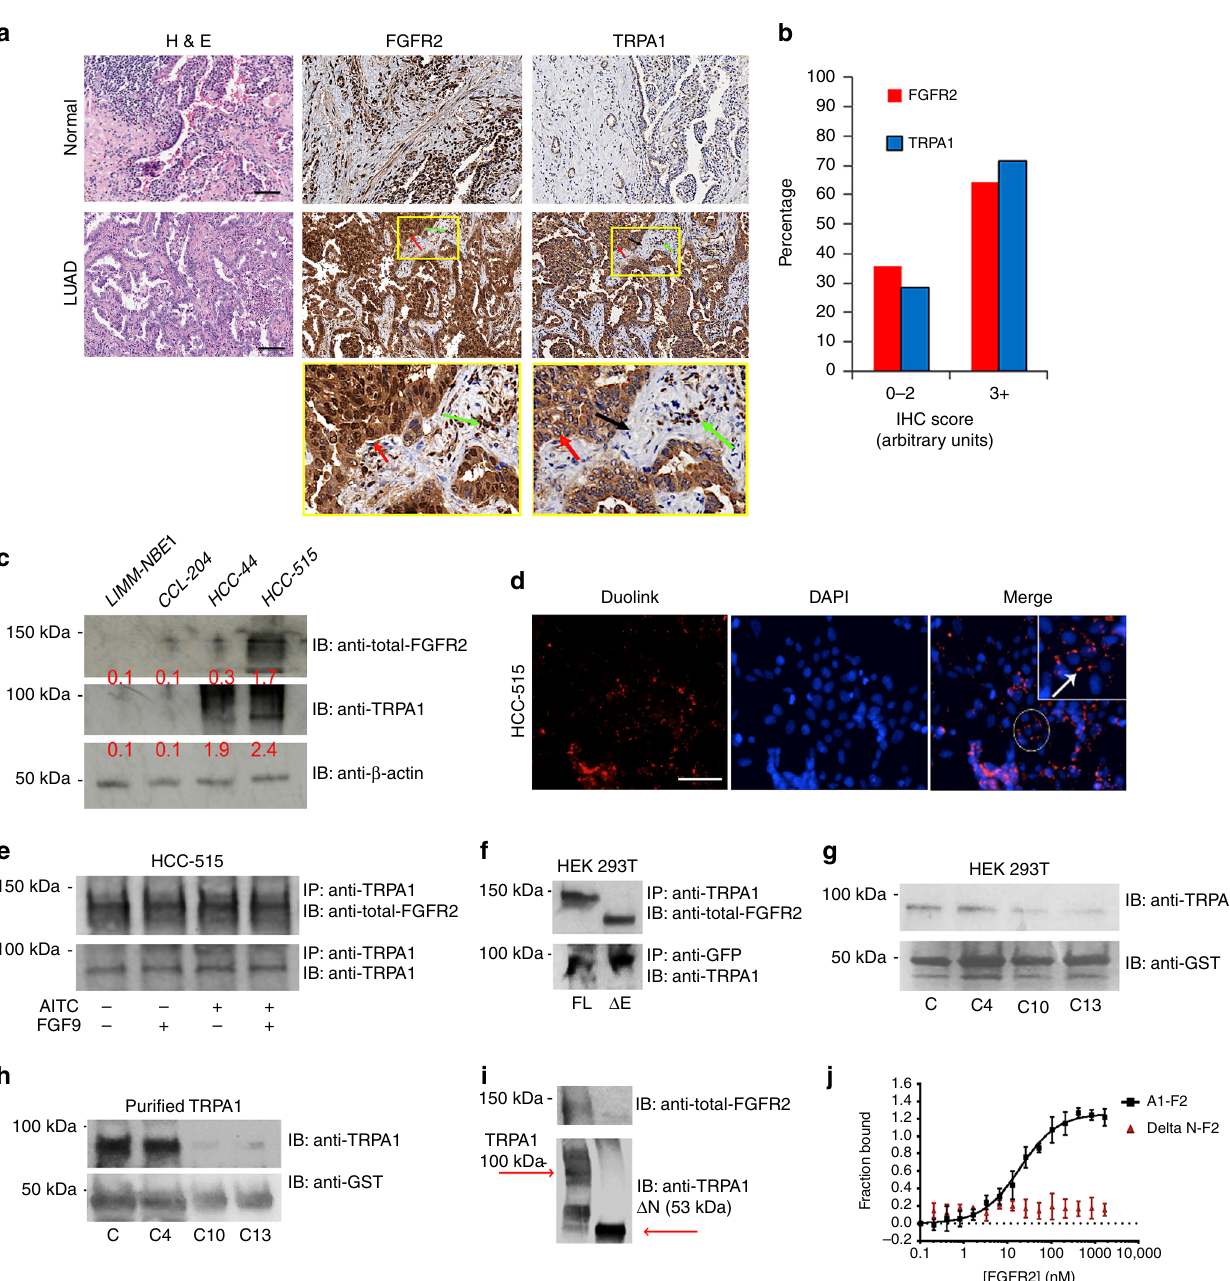
Fig. 1 FGFR2 binds directly to TRPA1 ankyrin repeats via its C-terminal proline-rich motif. a Representative image of haematoxylin and eosin (H&E) stain and immunohistochemistry (IHC) staining with FGFR2 and TRPA1 antibodies of a lung cancer tissue microarray. Scale bar: 10 μ m. Neoplastic epithelial cells are indicated by the red arrow, in fl ammatory cells by the green arrow, and supporting stroma ( fi broblasts) by the black arrow. b Fraction of total LUAD samples (in percentage) in the tissue microarrays (TMAs) with the indicated pathological scores. c Western blots for the expression levels of FGFR2 and TRPA1 in LIMM-NBE1, CCL-204, HCC-515, and HCC-44 cell lines. Normalized densitometric values (in relative arbitrary units) are reported in red below each band and represent the average of three independent experiments. d Duolink assay results with an example of a PLA signal depicted by the white arrow. Scale bar: 50 μ m. e Western blot analysis of an immunoprecipitation (IP with anti-TRPA1) in HCC-515 cell line followed by immunoblotting (IB) with the indicated antibodies. f Western blot analysis of an IP in HEK 293T cells transfected with full-length TRPA1 with either full-length FGFR2 (FL) or extracellular region-truncated FGFR2 ( Δ E). IP and IB were performed with the indicated antibodies. g GST pull-down results in HEK 293T cells transfected with TRPA1 and C, C4, C10, and C13 GST-constructs on GST beads. h GST pull-down experiment with full-length puri fi ed TRPA1 and C, C4, C10, and C13 GST-constructs on GST beads. i Western blot analysis of puri fi ed biotinylated full-length TRPA1 or ankyrin repeats-truncated TRPA1 ( Δ N) proteins immobilized on streptavidin beads and incubated with full-length puri fi ed FGFR2. j Microscale thermophoresis (MST) curve of puri fi ed full-length FGFR2 (F2; titrated in a range of concentrations) with puri fi ed full-length TRPA1 (A1) or Δ N. Apparent dissociation constant K d for A1-F2 was 122.8 ± 23.4 nM. Error bars represent the s.d. of each data point ( n =